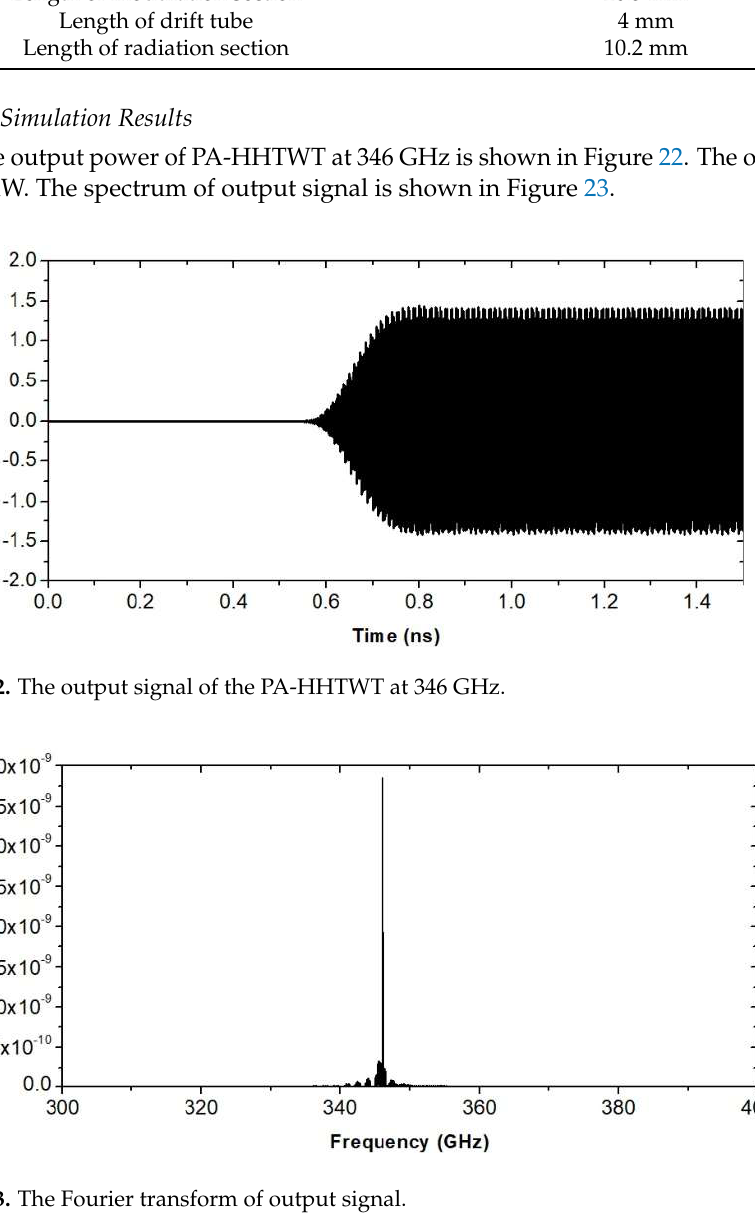
Table 4. Parameters of the PA-HHTWT.